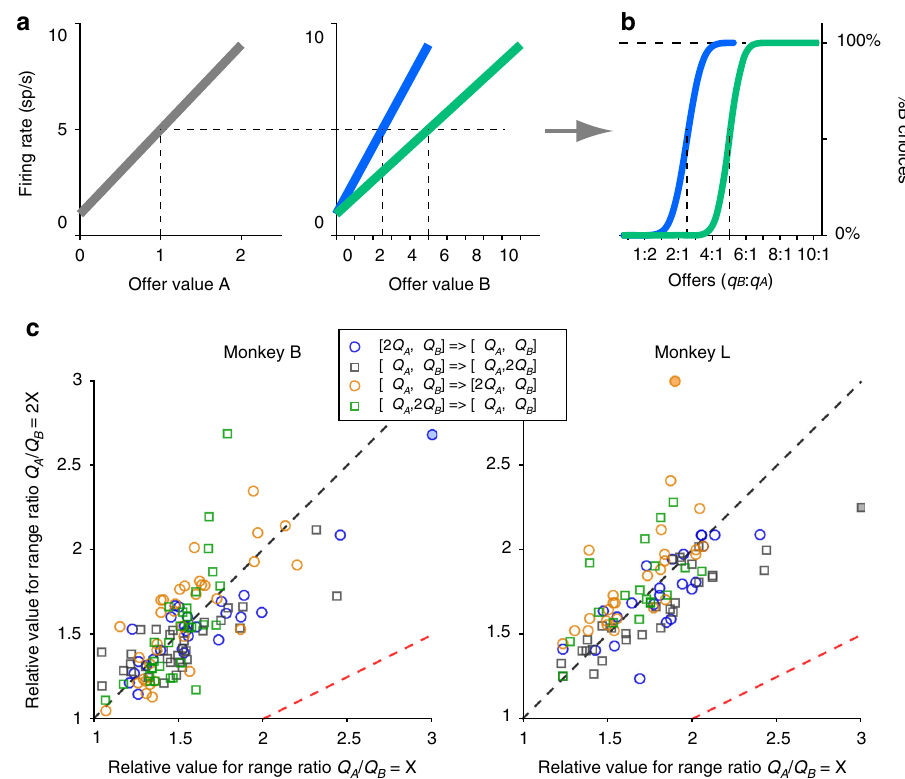
Fig. 3 Range adaptation is corrected within the decision circuit. a , b Uncorrected range adaptation would induce arbitrary choice biases. Panel a shows the schematic response functions of two neurons encoding the offer value A (left) and the offer value B (right). Panel b shows the resulting choice patterns under the assumption that decisions are made by comparing the fi ring rates of these two cells. We consider choices in two conditions, with the range Δ A